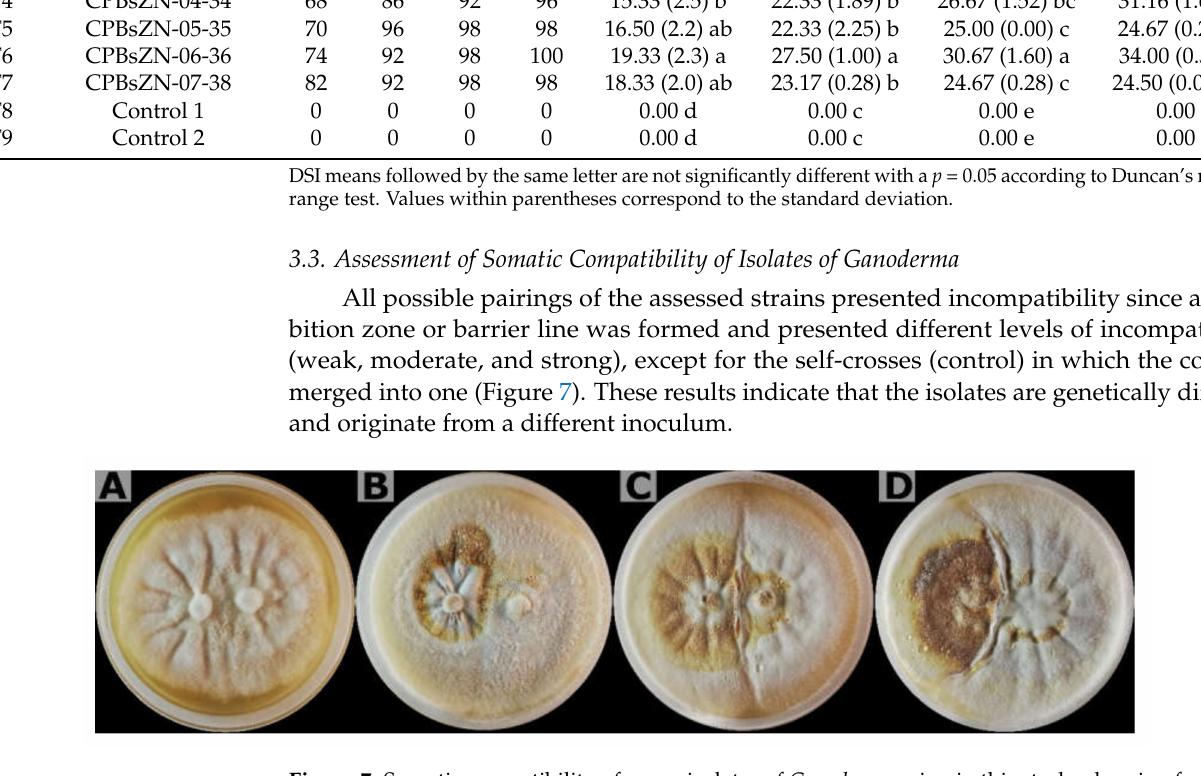
Figure 7. Somatic compatibility of seven isolates of Ganoderma using in this study, showing formation of inhibition zone or barrage in incompatible reactions. ( A ) compatible reaction of self-pairing (control) between CPBsZN-01-29; ( B ) incompatible reaction between isolates CPBsZN-03-31 and CPBsZN-07-38 (weak interaction); ( C ) incompatible reaction between isolates CPBsZN-04-34 and CPBsZN-05-35 (moderate interaction); and ( D ) incompatible reaction between isolates CPBsZN-02-30 and CPBsZN-03-31 (strong